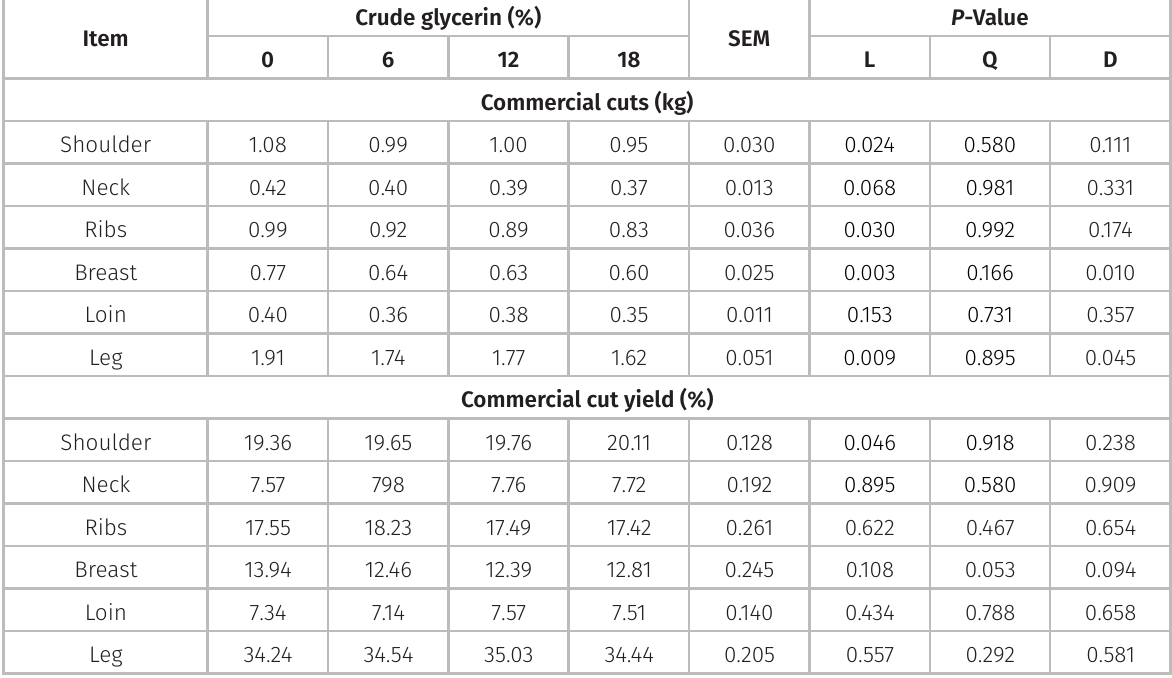
Table III. Commercial cut weight and yield of goats fed diets containing increasing levels of crude glycerin containing 63.06% glycerol and 45.57%